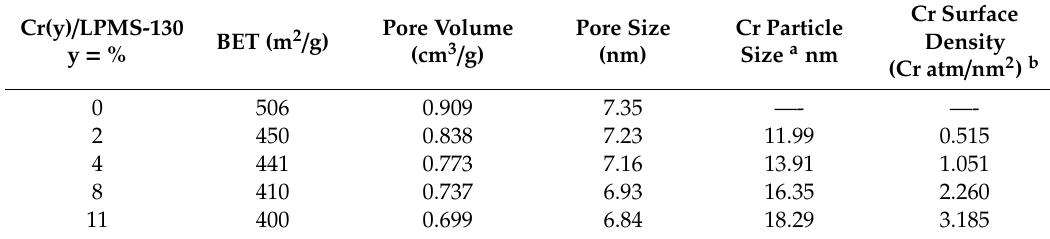
Table 2. Textural properties of Cr(y) / LPMS-130 prepared with di ff erent chromium loading wt %. Cr(y) / LPMS-130 y =